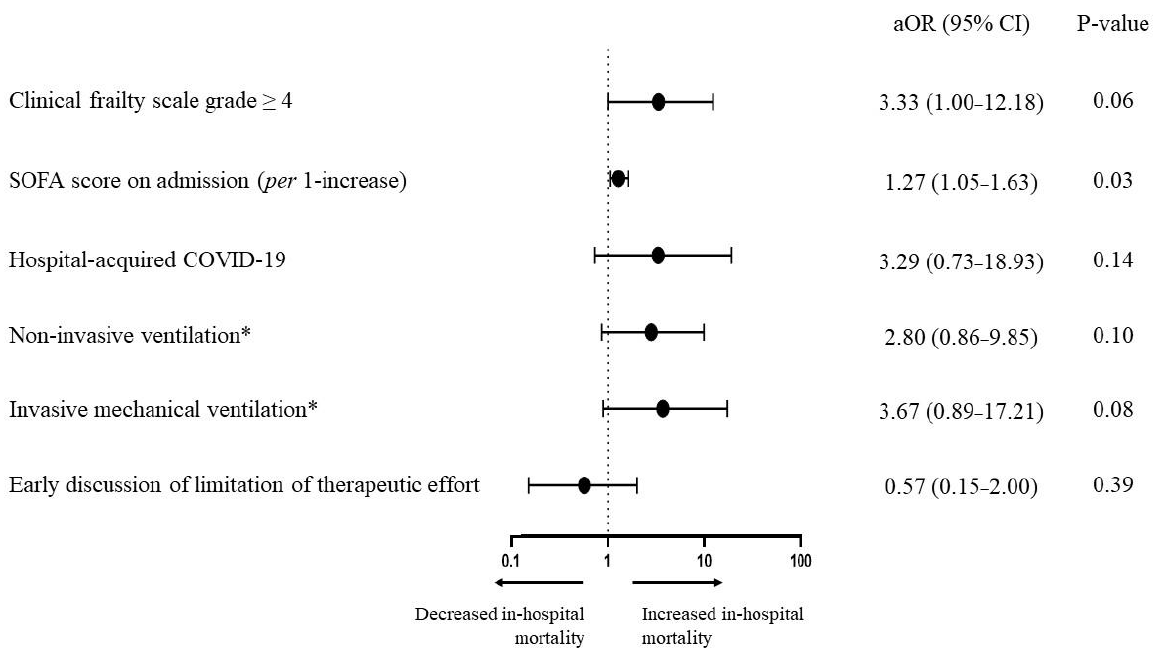
Figure 2. Forrest plot representing the odds ratios of in-hospital mortality according to the clinical frailty scale grade, the hospital-acquired origin of COVID-19, the ventilation support modality initiated during the first 24 h and the early discussion of limitation of therapeutic effort. Comparisons were performed using a multivariable logistic regression model. Points represent the adjusted odds ratios and lines represent 95% confidence intervals. * Compared with high-flow nasal oxygen or conventional oxygen taken as reference. aOR, adjusted odds ratio; CI, confidence interval; SOFA, Sequential Organ Failure Assessment.